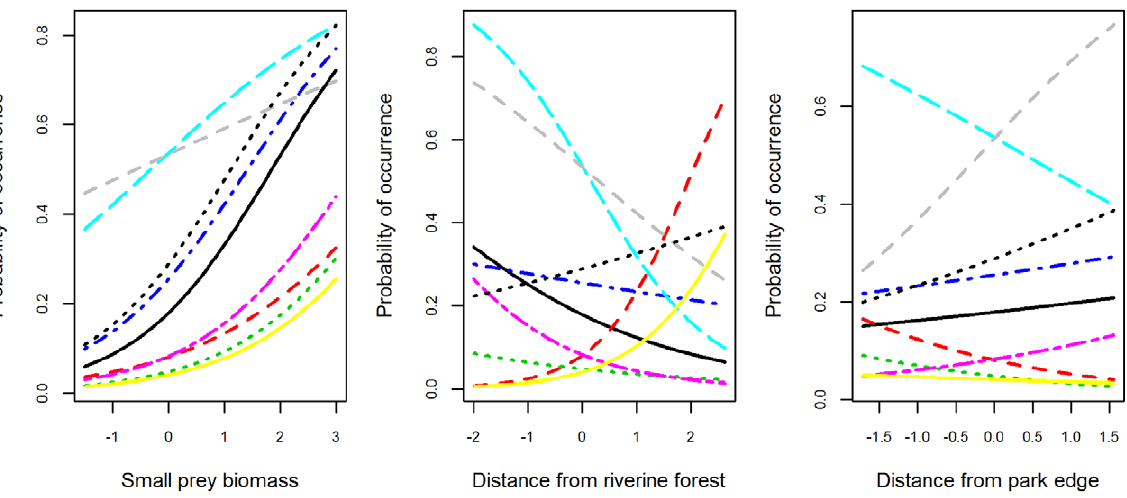
Figure 2. Model-predicted carnivore responses to the three site covariates included in the best occurrence model. Predicted marginal probabilities of carnivore occurrence relative to variation in the index of small prey biomass, distance from riverine forest, and distance from park edge (all values standardized). Species are: African civet (solid black), caracal (dashed red), Gambian mongoose (dotted green), large-spotted genet (dot-dash blue), leopard (dashed light blue), marsh mongoose (dot-dash purple), side-striped jackal (solid yellow), spotted hyena (dashed grey), white-tailed mongoose (dotted black; scientific names and details of model selection are given in the text). doi:10.1371/journal.pone.0038007.g002 highest posterior model probabilities (Table 4). A total of 64 candidate models appeared in the posterior sample, but the four highest-ranked models had 70% of the support, and 90% of the posterior model probability was captured by 11 candidate models (Table 4). The top-ranked model contained additive effects of edge, riverine forest and small prey biomass on occurrence, and of road and team on detection (Pr = 0.335; Table 4). Predicted occurrence probabilities from the best model indicated significant heterogeneity among species in the direction and magnitude of their responses to site covariates (Fig. 2).